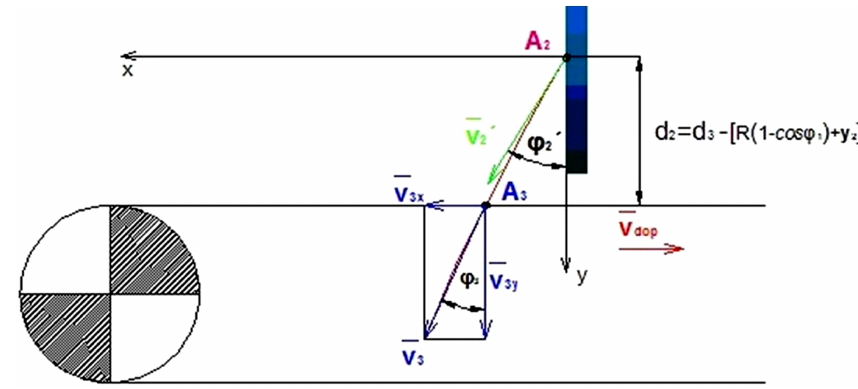
Figure 5. Decomposition of velocity components at the point of the material particle’s impact on the